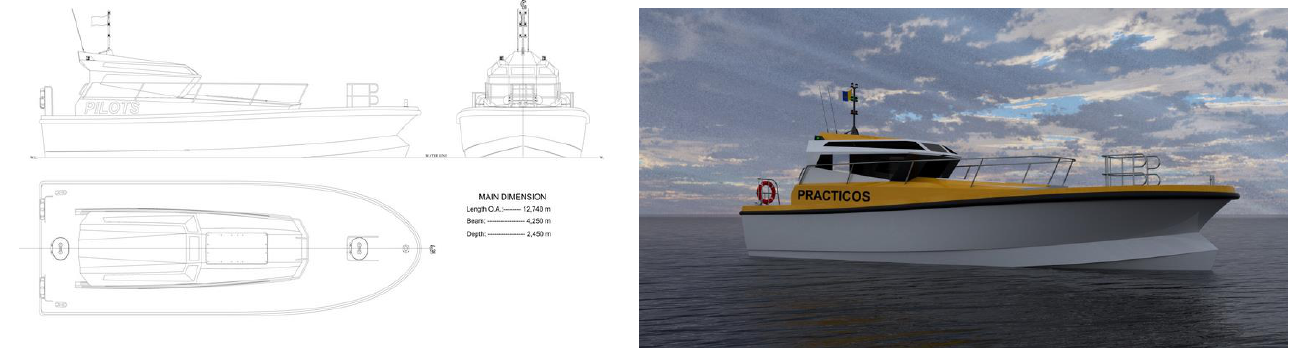
Figure 2. Pantocaréne Hull (www.bairdmaritime.com (accessed on 1 September 2022)). Figure 2. Pantocar é ne Hull (www.bairdmaritime.com (accessed on 1 September